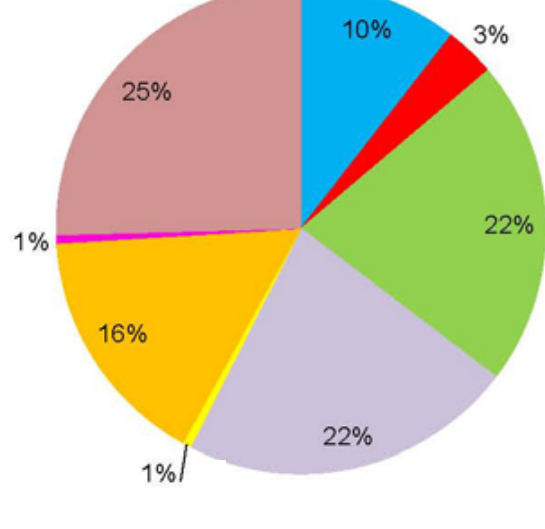
Figure 11: Activity types (by overarching group) predominantly concerned with research production and/or communication and the mechanisms used (shown as